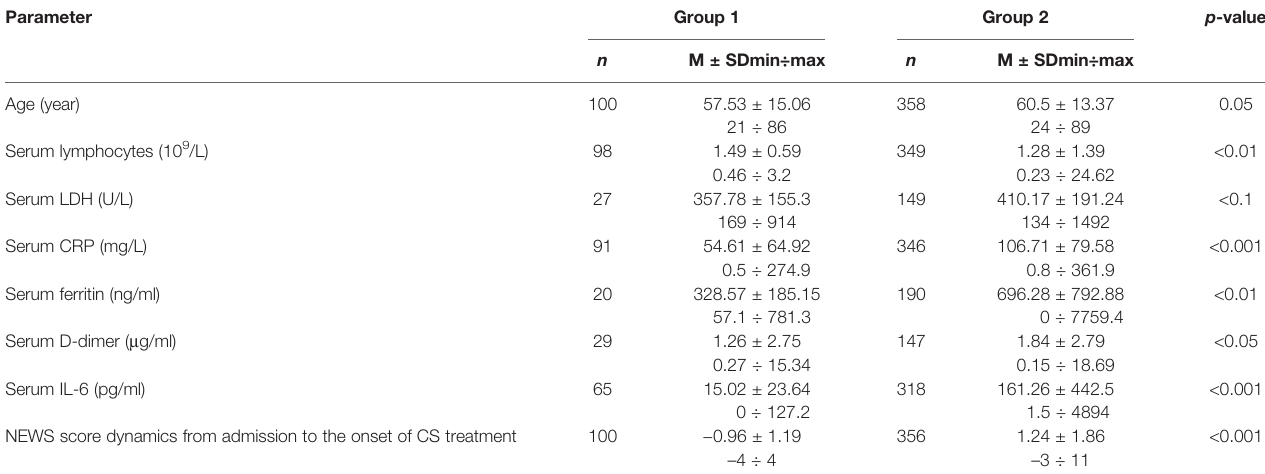
TABLE 4 | Comparative analysis of basic variables for CS diagnosis at the onset of proactive anti-in fl ammatory treatment.